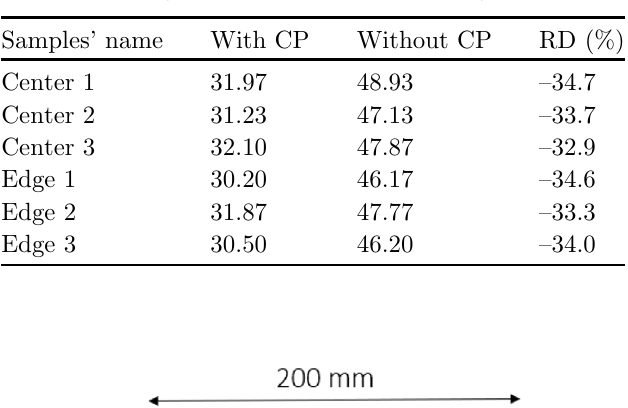
Table 3. Haze factor (%) and relative difference (RD) between cooling with or without the Cooling